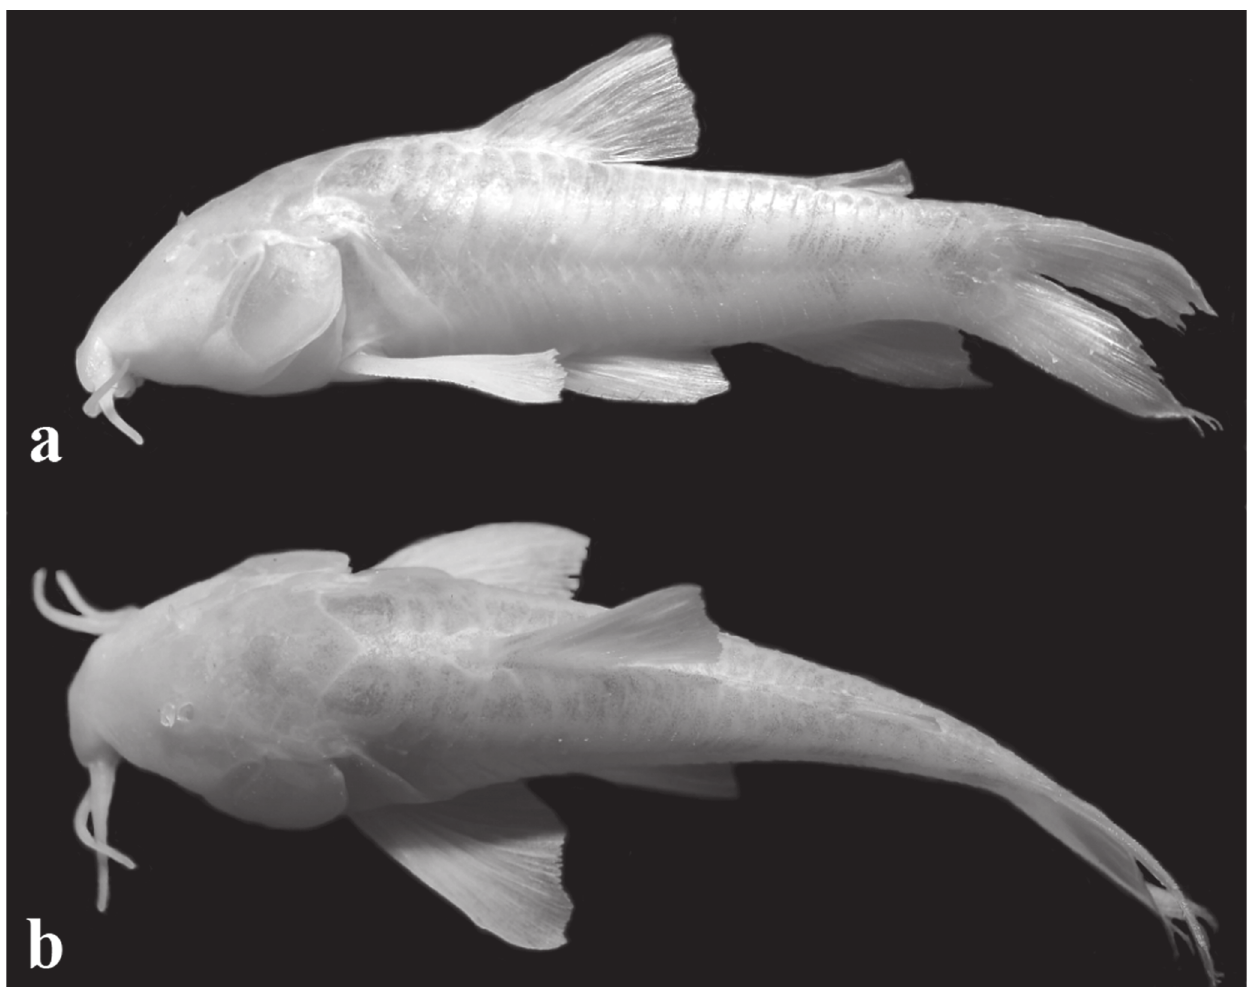
Fig. 2. Aspidoras albater , MZUSP 95905, 35.1 mm SL, from Anésio III cave, Goiás, Brazil. a ) Lateral view; b ) dorsal view. Photo Alexandre